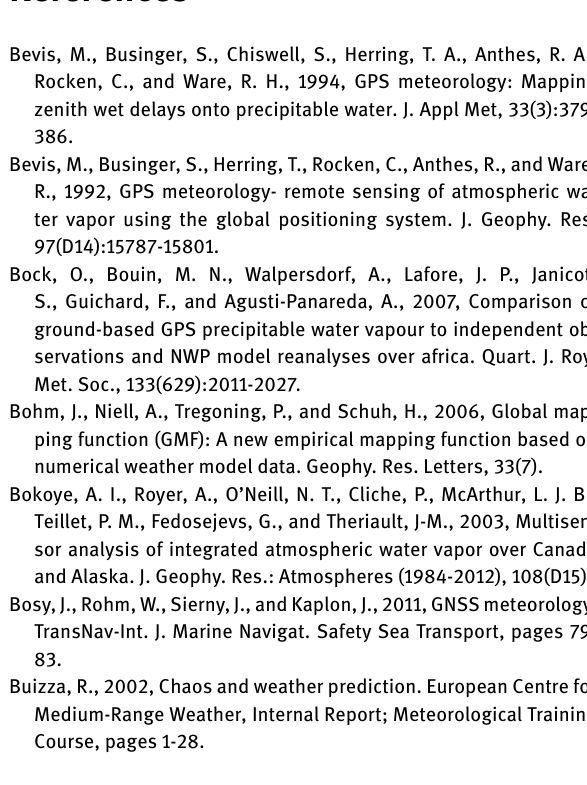
synoptic stations and GNSS continuously operating Base Stations as shown in Fig. 7. In all a minimum of 19